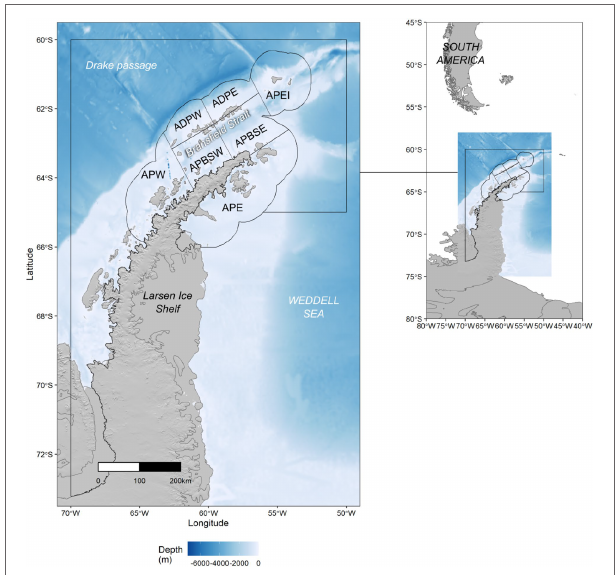
FIGURE 1 | Map of the Antarctic Peninsula, Western Antarctica, showing Subarea 48.1 (black bounding box). Within Subarea 48.1, seven Small Scale Management Units (SSMUs) are indicated; APW, Antarctic Peninsula West; APDPW, Antarctic Peninsula Drake Passage West: APDPE, Antarctic Peninsula Drake Passage East; APEI, Antarctic Peninsula Elephant Island; APBSW, Antarctic Peninsula Bransfield Strait West; APBSE, Antarctic Peninsula Bransfield Strait East: APE, Antarctic Peninsula